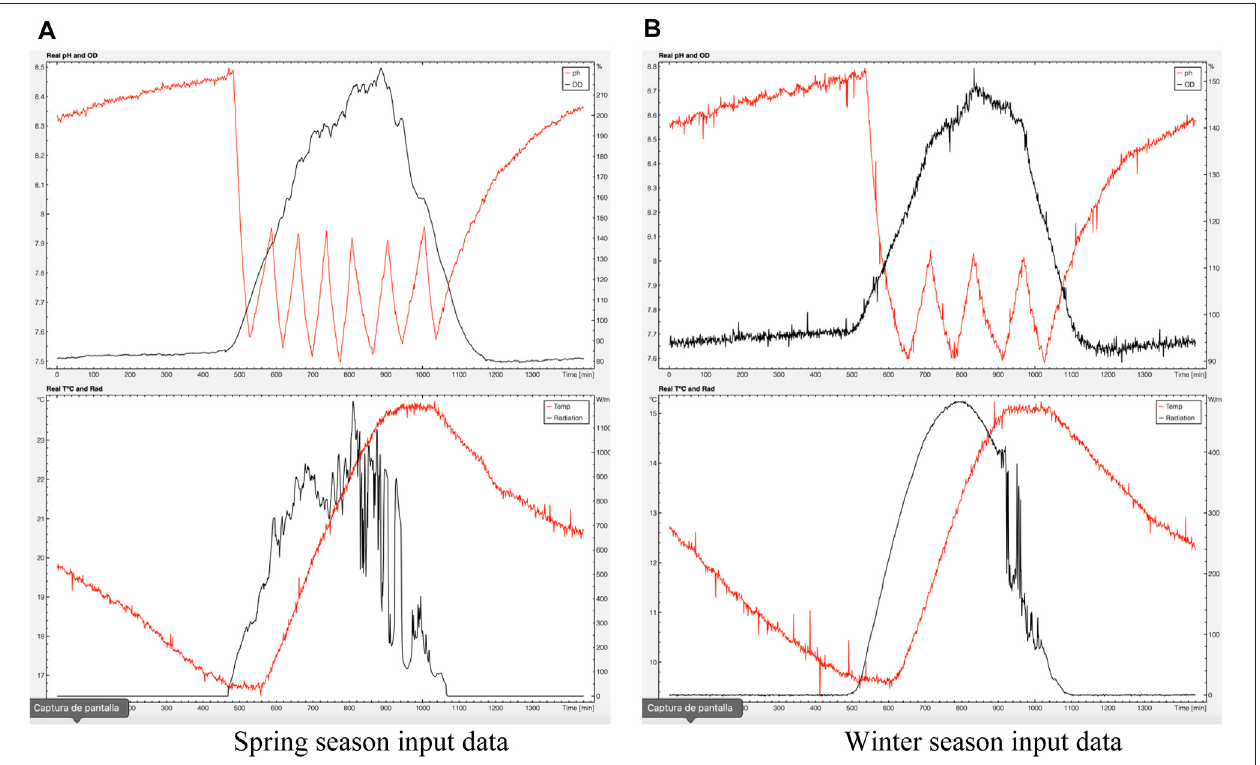
FIGURE 6 | Real input data for the examples showed in Figure 2 to demonstrate the environmental variables effect on the productivity of the microalgae systems.